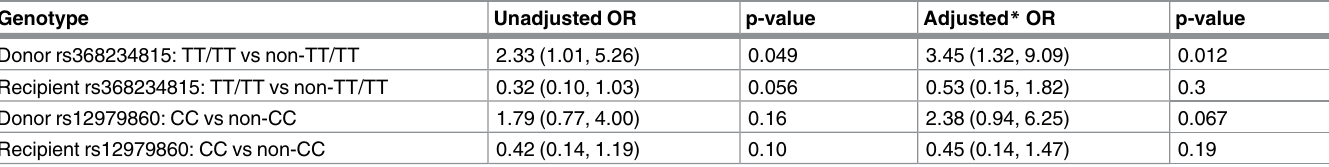
Table 3. Adjusted Comparison of